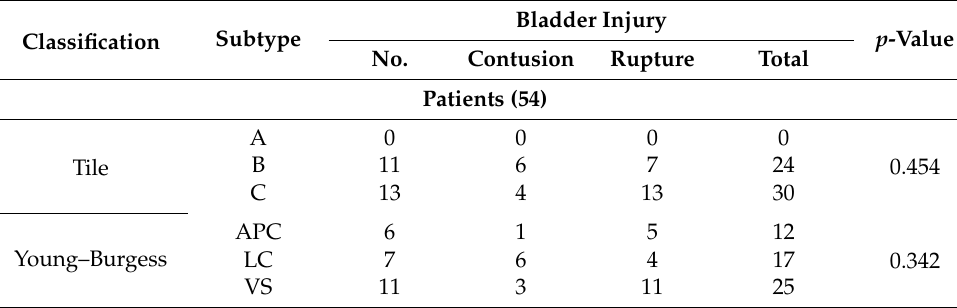
Table 3. Fracture pattern and injury to the bladder ( n = 54).